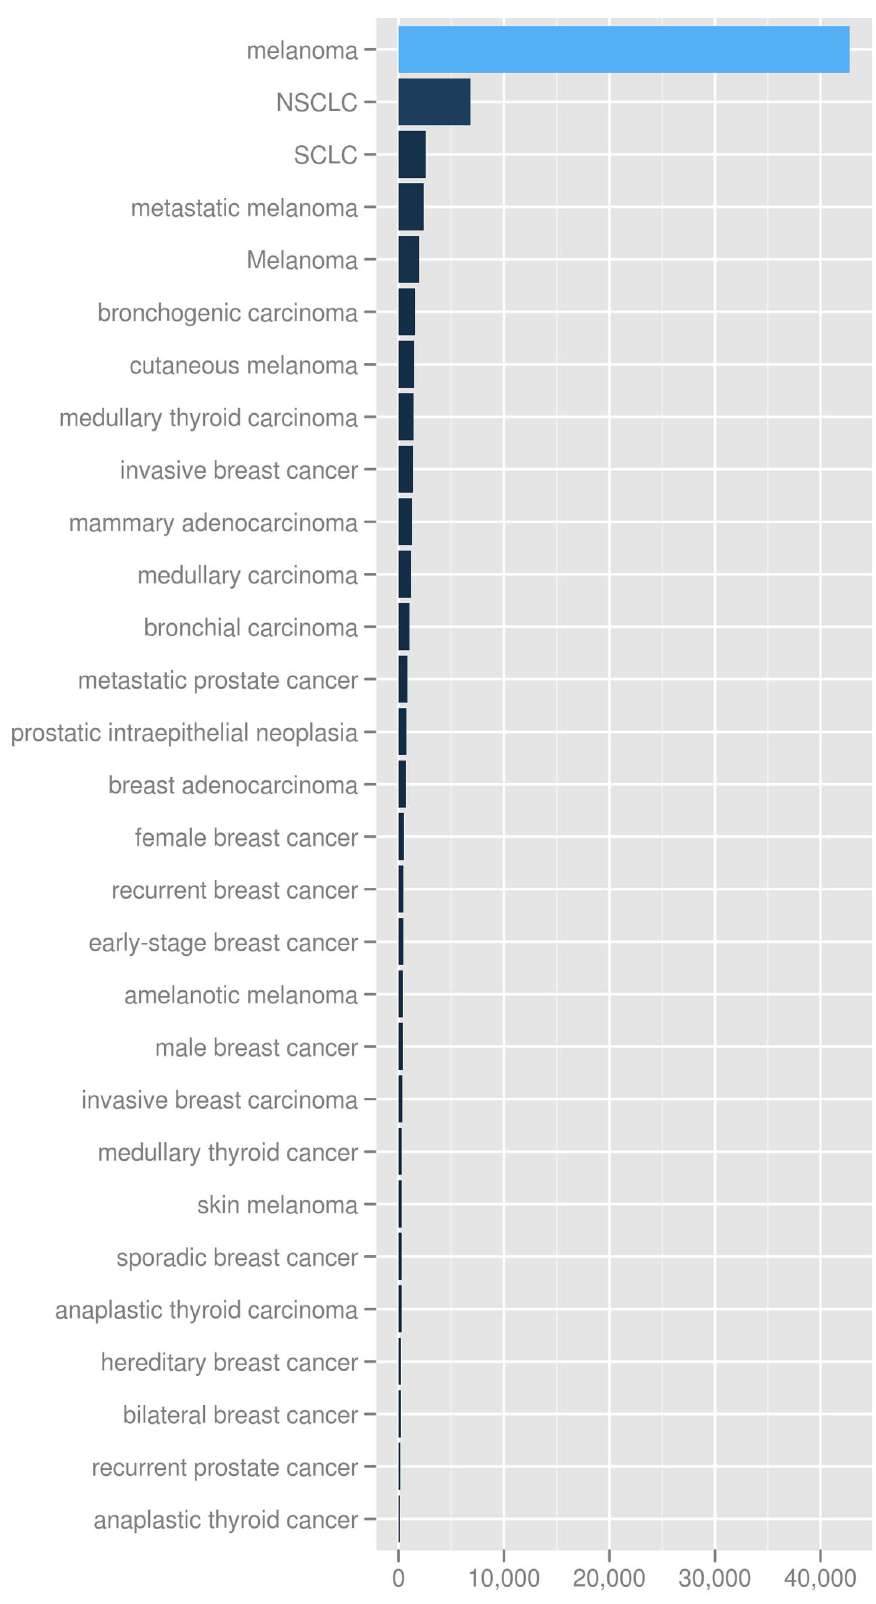
Figure 1. Cancer term occurrences in the literature. A bar chart representation with cancer terms on the y-axis and publication counts on the x- axis. Only the cancer terms with high literature occurrences are shown.